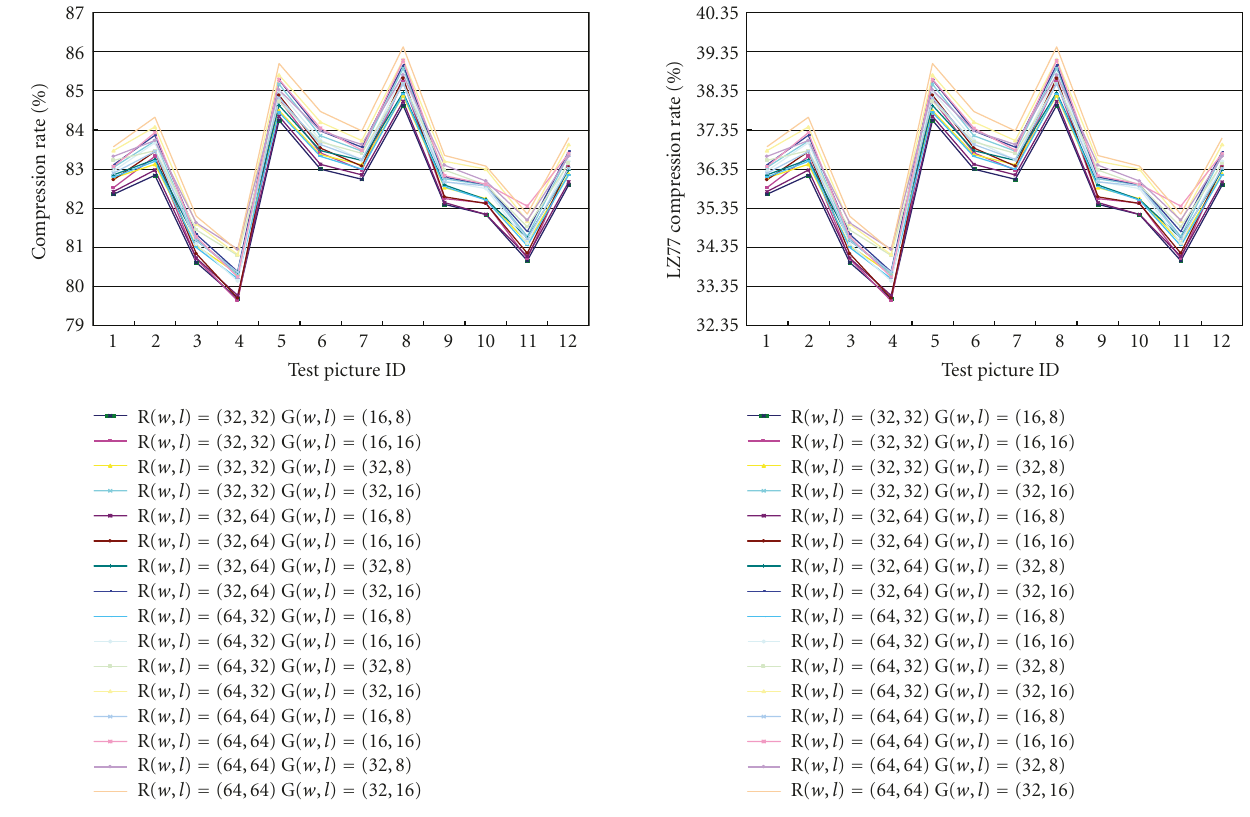
Figure 12: The compression performance of LZ77 coding that combines with the quantization in the GICam-II image